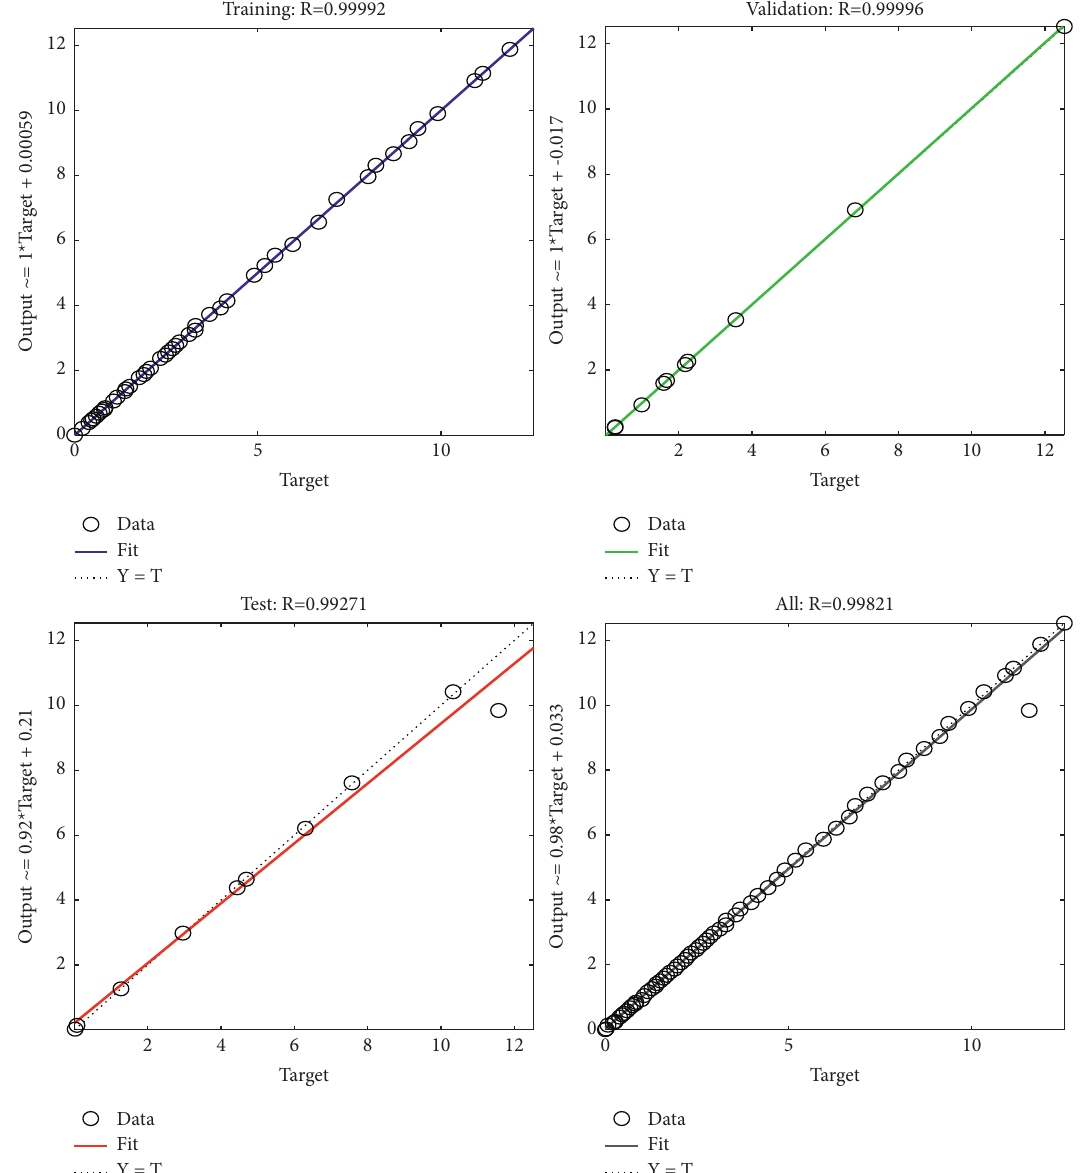
Figure 10: Neural network training regression analysis (optimal performance at 40 neurons in the hidden layer for Scheme